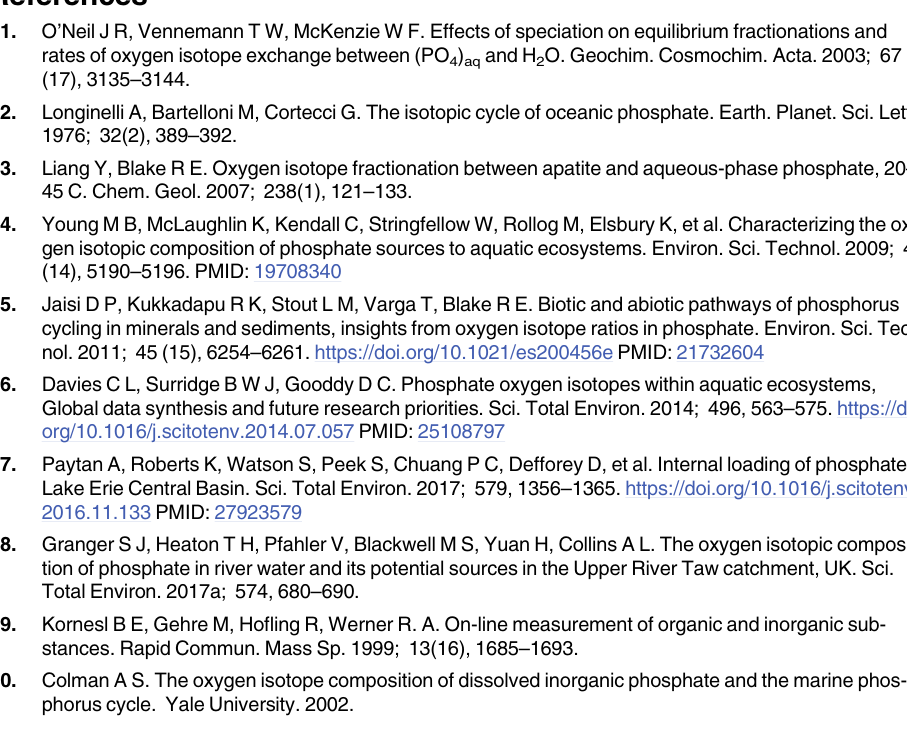
S4 Table. Stable oxygen isotope values of the prepared silver phosphate by different meth- ods. (a): Prepared from KH for the aqueous ammonia recrystallizatione. (b): Prepared from KH nological processes in this study. (c): Synthesized directly by KH